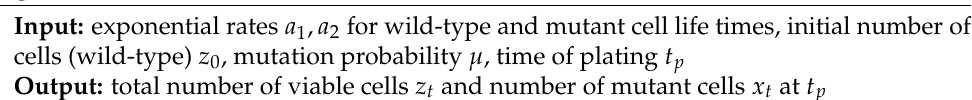
Algorithm 2 Alternative simulator based on an STBP